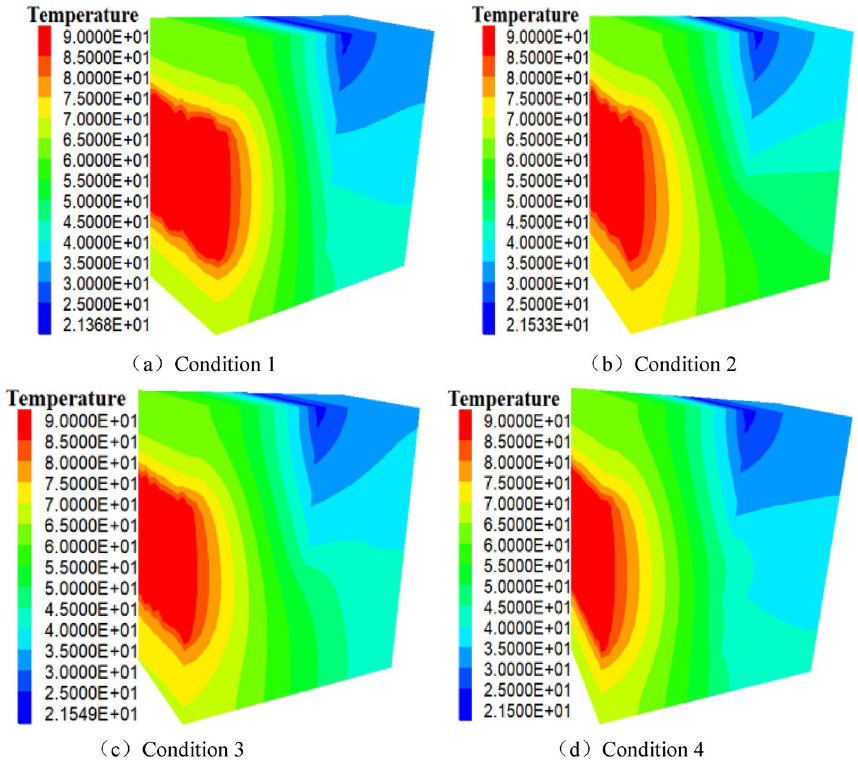
Figure 3. Temperature field of rock mass (unit: